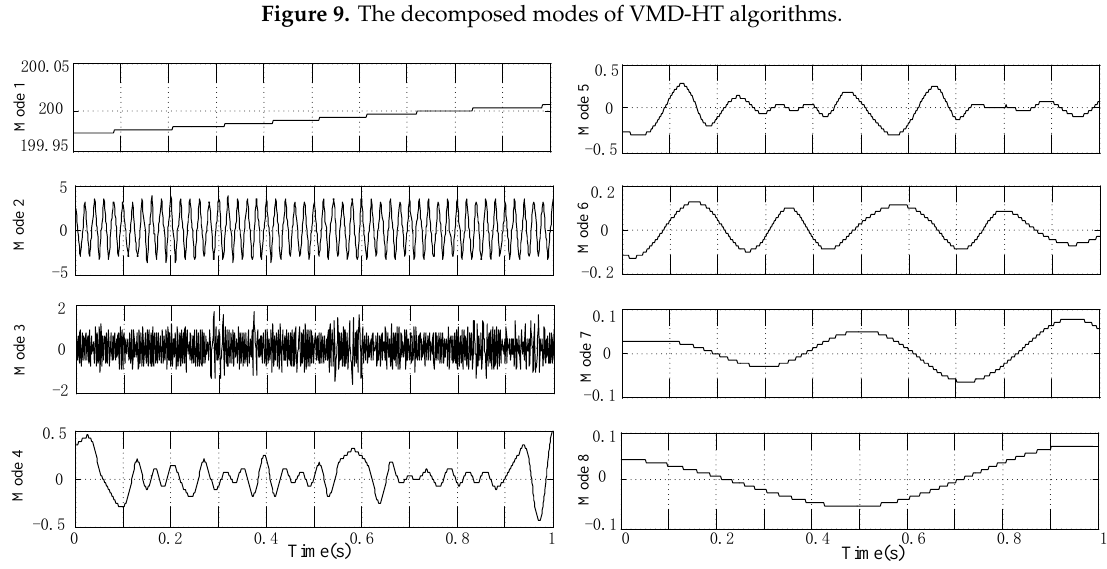
Figure 10. The decomposed modes of EMD algorithms.